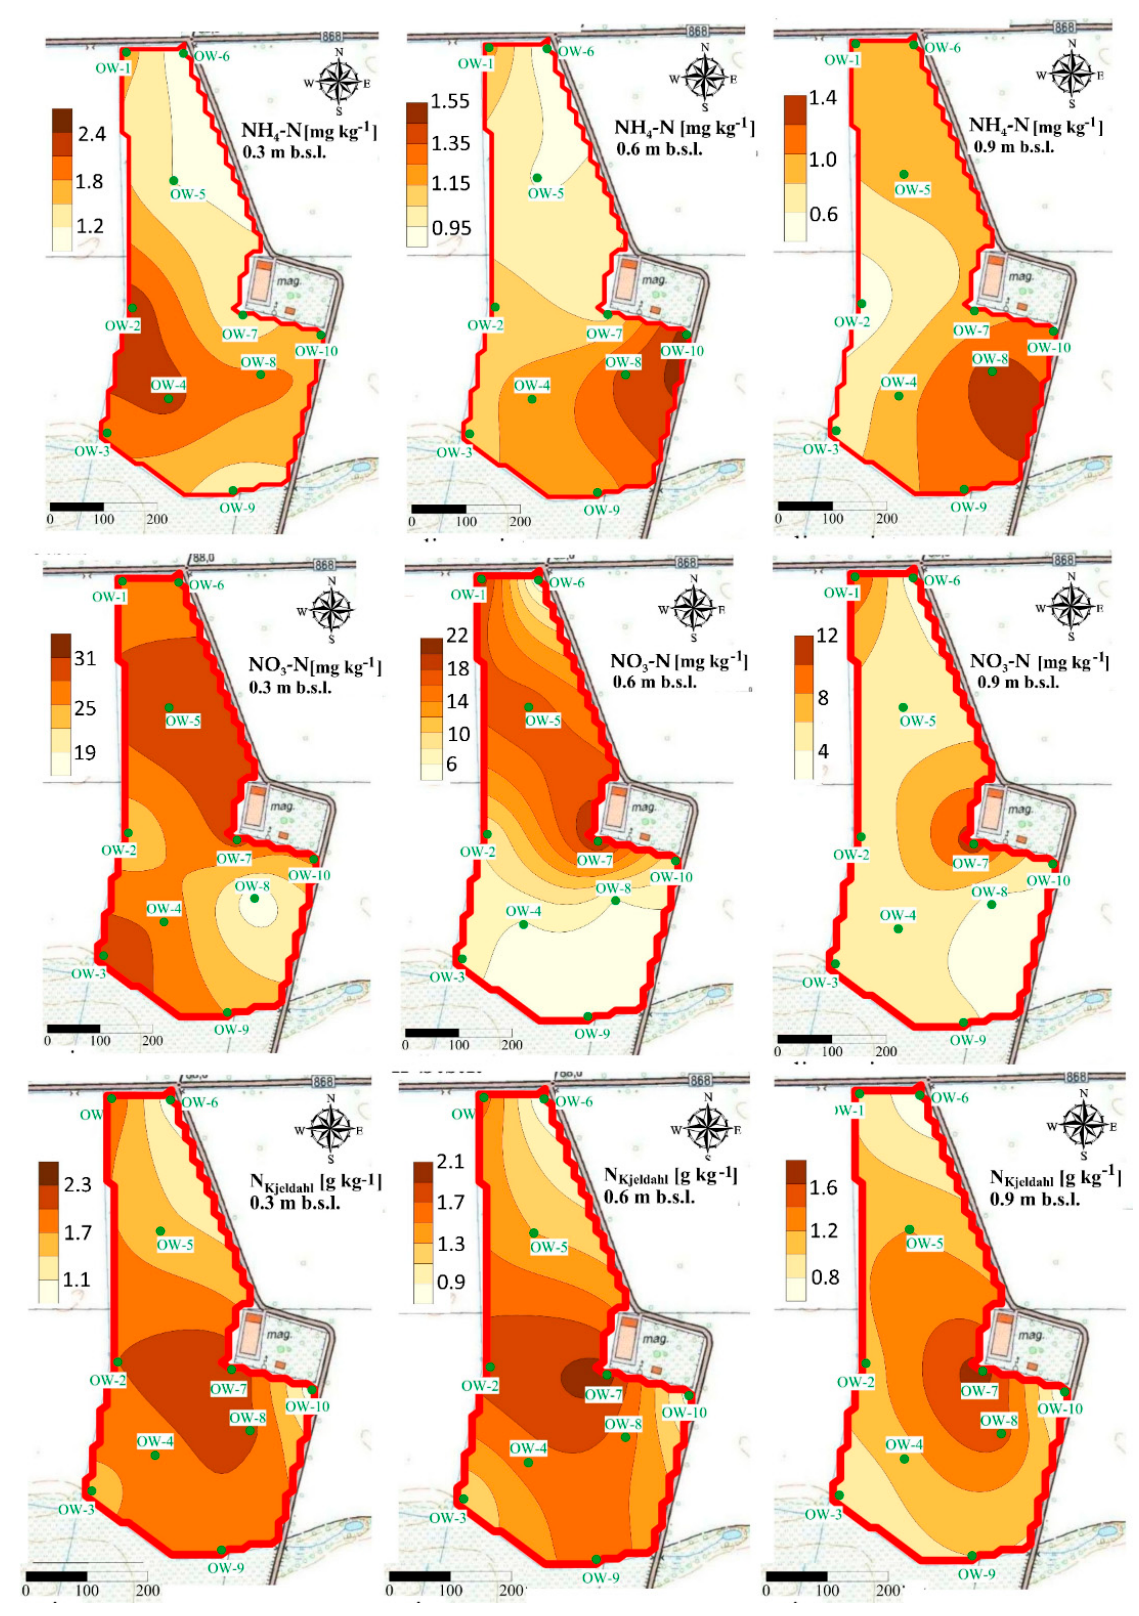
Figure 13. Spatial distribution of ammonium, nitrate, and N Kjeldahl in soil at the C experimental site after VRA fertilization.